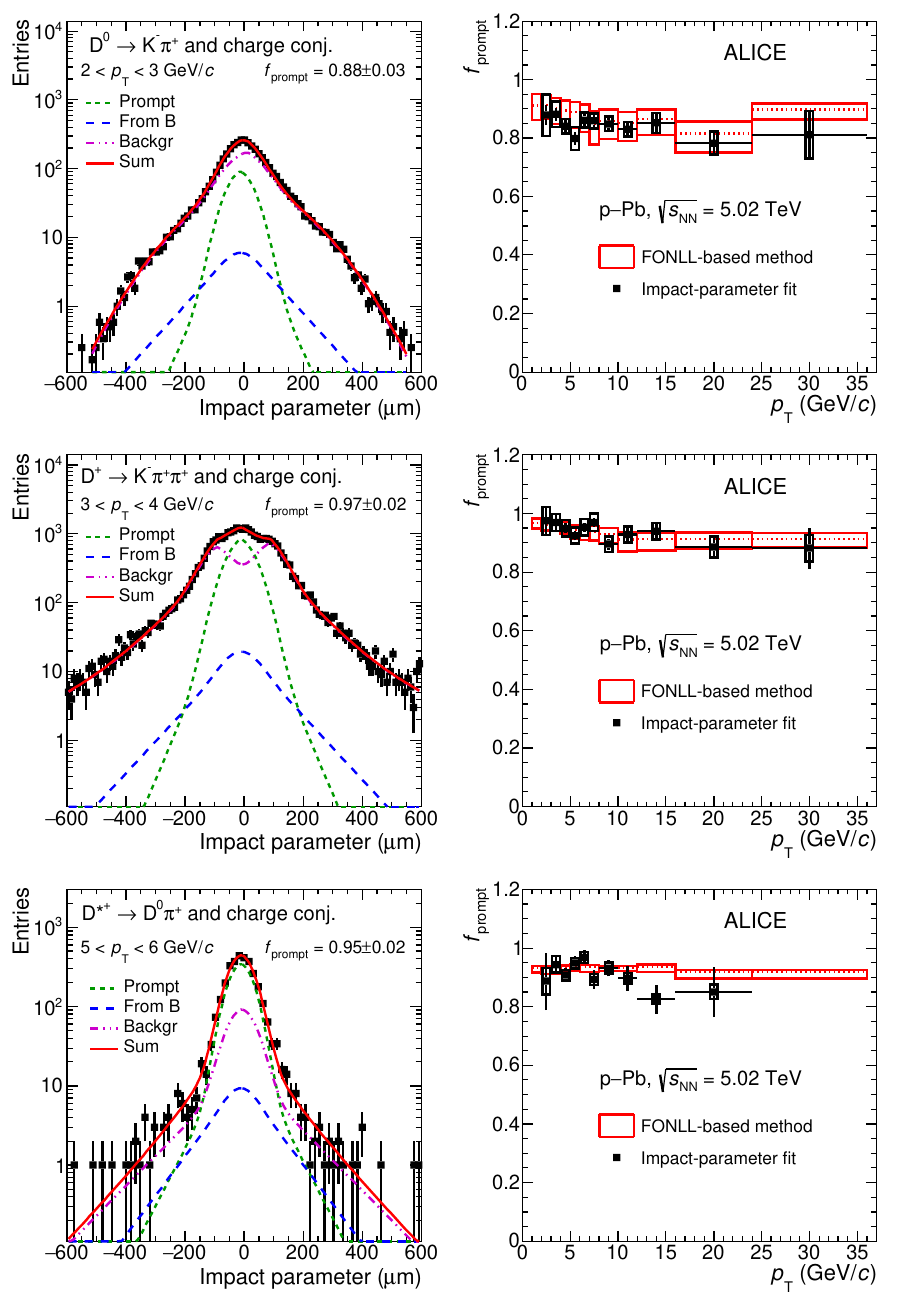
Figure 5 . Left: Exemplary (cid:12)ts to the impact-parameter distributions of D 0 , D + , and D (cid:3) + can- didates. The curves show the (cid:12)t functions describing the prompt, feed-down, and background contributions as well as their sum, as described in the text. Right: fraction of prompt D 0 , D + , and D (cid:3) + raw yield as a function of transverse momentum p T compared with the values obtained with the FONLL-based approach. The results from the data-driven method are shown as square markers with the error bars (boxes) representing the statistical (systematic) uncertainty. The central values of f prompt from the FONLL-based approach are shown as the dashed lines and the uncertainty as red boxes.